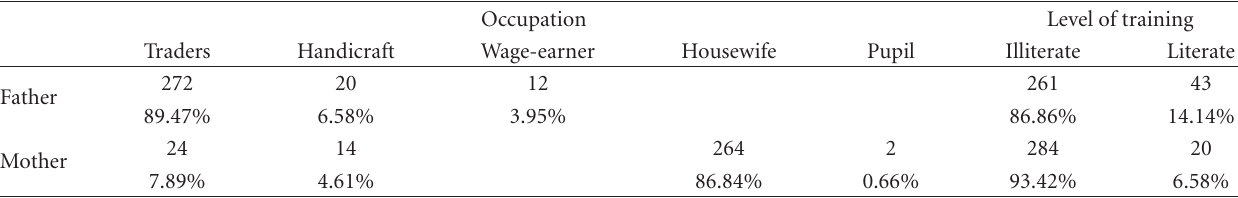
Table 1: Parents’ jobs, educational